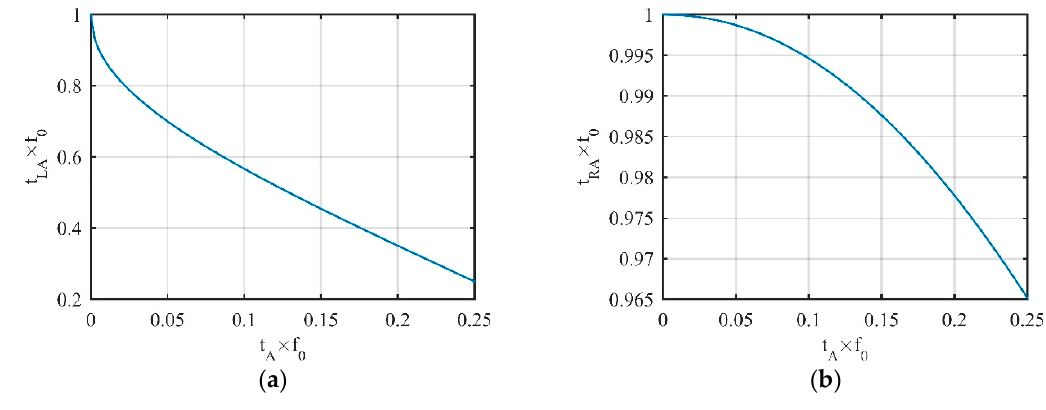
t and ( b ) t with t . Figure 2. Change laws of ( a ) Figure 2. Change laws of ( a ) t LA and ( b ) t RA with t A . t and ( b ) t with t . LA RA A Figure 2. Change laws of ( a ) LA RA A t , which means any point in the and RA t . A more intuitive schematic diagram is shown in Figure 3. A